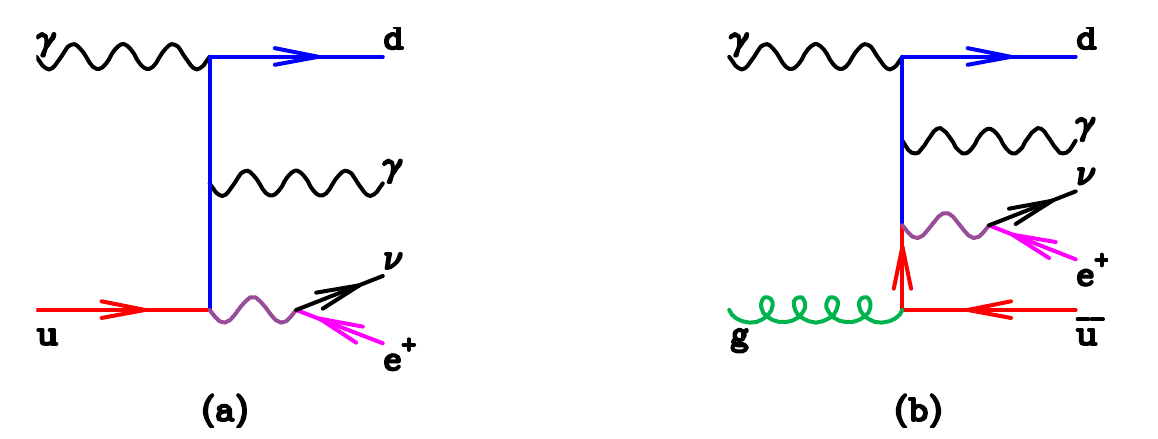
Figure 3 . Representative photon-induced diagrams (a) for the process in eq. (5.3) and (b) for the process in eq.